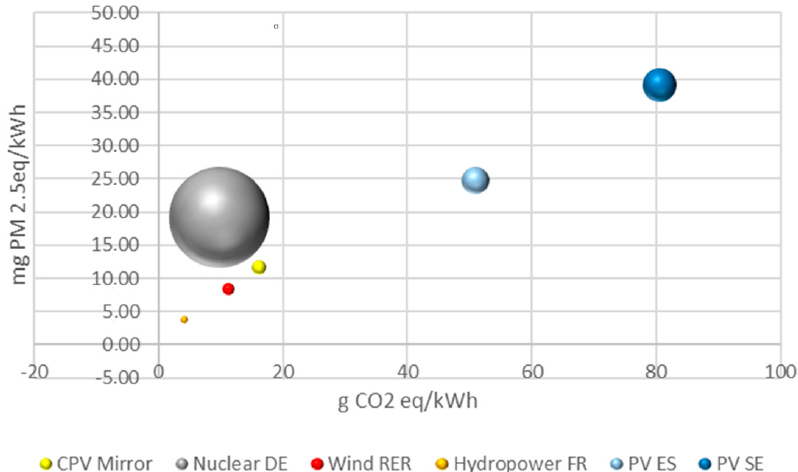
Figure 8. Environmental impact of low carbon energy sources. Energy demand (MJ) compared to particulate matter emissions (PM 2.5 -eq) and climate change (g CO 2 -eq). The size of the bubbles is proportional to their non-renewable primary energy demand, calculated using the CML methodology [69]. The two other impact categories stem from the ILCD Midpoint 2011 methodology. From left to right in the legend, energy demand is, respectively, 0.2, 11.6, 0.2, 0.05, 0.8, and 1.3 MJprim/kWh. HCPV results are compared with EcoInvent data for low carbon electricity sources. HCPV performances are promising. Both in terms of carbon footprint and particle emissions, HCPV modules are in the low part of the curve with respectively less than 20 g CO 2 -eq/kWh, about